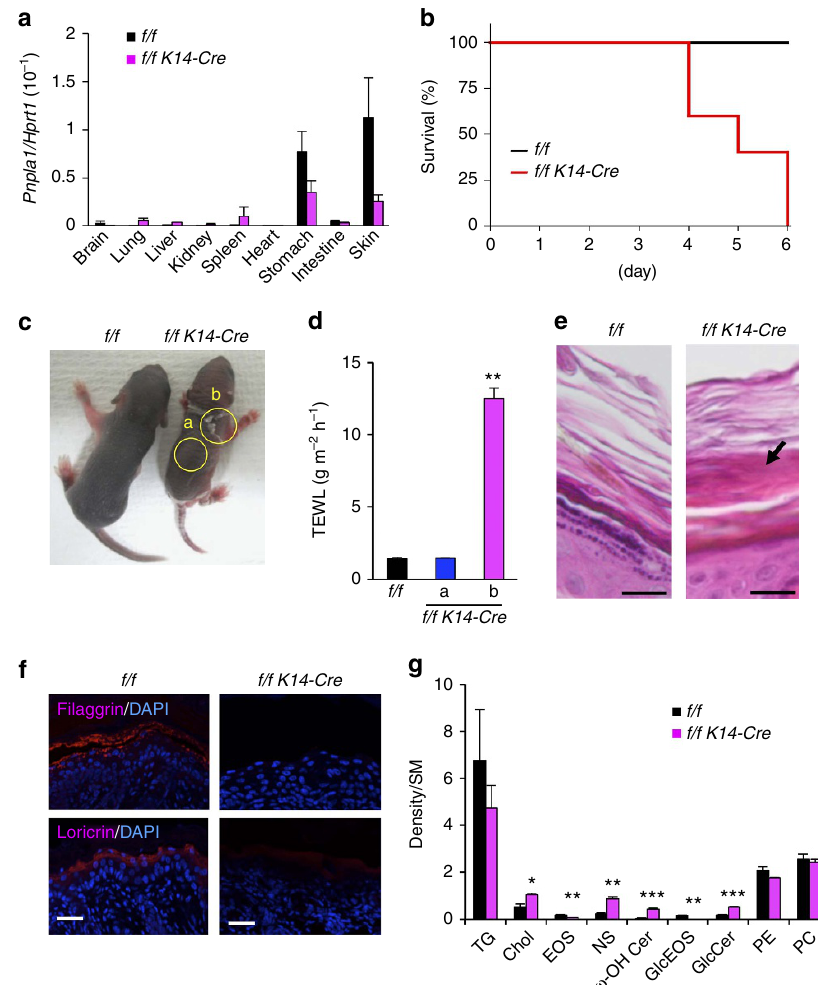
Figure 4 | Phenotypes of keratinocyte-specific Pnpla1 -deficient mice. ( a ) qPCR analysis of Pnpla1 expression in various tissues of control ( f/f ) ( n ¼ 2) and Pnpla1 f/f K14-Cre ( f/f K14-Cre ) ( n ¼ 4) mice at P5. ( b ) Postnatal death within 6 days due to epidermal-specific disruption of Pnpla1 ( n ¼ 5 per genotype). ( c ) Gross appearance of control ( f/f ) and mutant ( f/f K14-Cre ) mice at P5. Mutant animals showed smaller body size. Yellow circles labelled with a , b indicate regions without and with severe desquamation, respectively. ( d ) TEWL of control ( n ¼ 13) and mutant ( n ¼ 18) mice at P5. Labels a , b are as indicated in c . ( e ) Representative images of hematoxylin-eosin staining of skin sections from control and mutant mice at P5. In mutant mice, the lower part of the SC layers became densely packed with poor lipid interspaces (arrow). ( f ) Impaired terminal differentiation of epidermal keratinocytes at P5 in Pnpla1 f/f K14-Cre mice. Sections were stained with anti-filaggrin and anti-loricrin antibodies (red) and DAPI (blue). ( g ) Densitometric analysis of TLC separation of epidermal lipids extracted from control and mutant mice at P5. Individual lipid levels were normalized with SM content ( n ¼ 6 animals). In a , d , g , values are mean ± s.e.m.; * P o 0.05, ** P o 0.01 and *** P o 0.001 versus control mice. Scale bars in e , f , 20 m m. Data are from at least two independent